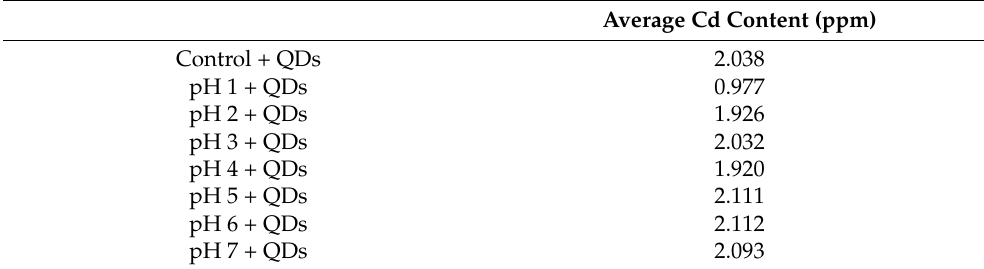
Table 3. Agglomeration assay. QDs incubated in water with a pH ranging from 1 to 7 and incubated for 24 h. The samples were spun to isolate largely agglomerated QDs at the bottom; the supernatant was then tested using ICP-OES.